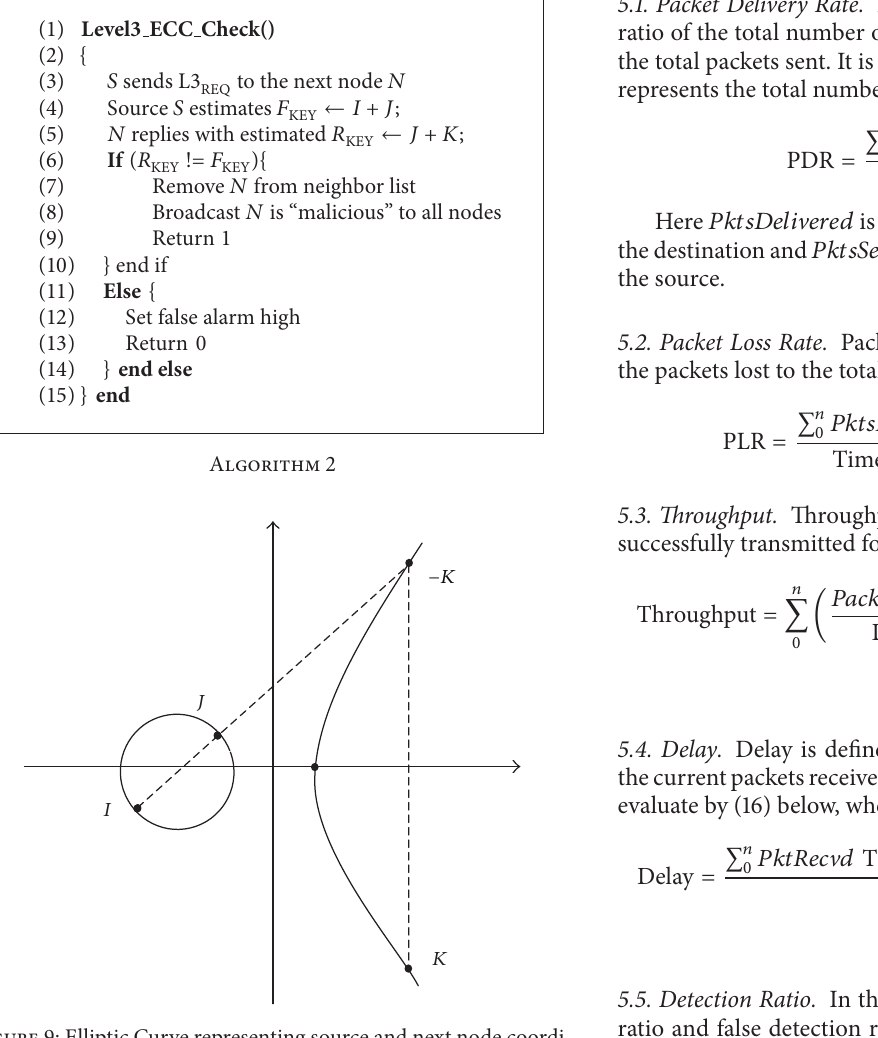
Figure 9: Elliptic Curve representing source and next node coordi- nates 𝐼 and 𝐽